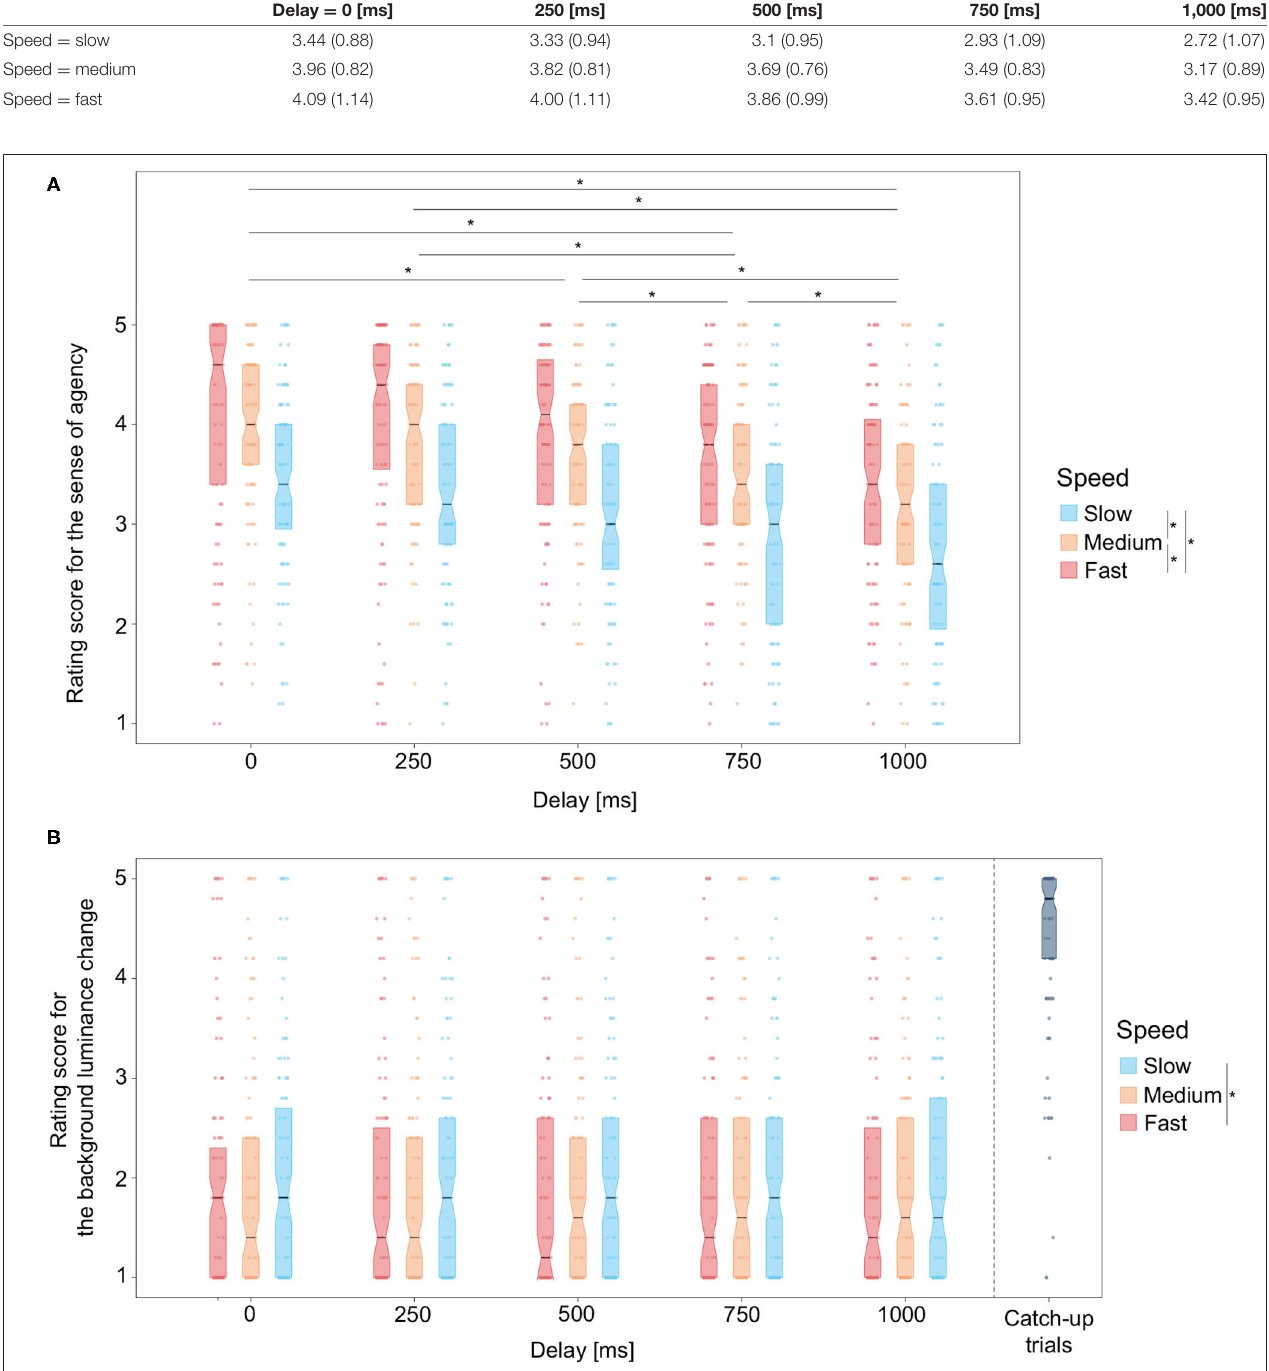
FIGURE 4 | Experiment 2 results. Box plots of (A) sense of agency rating scores and (B) background-luminance rating scores for each of the speed conditions as a function of the delay. Asterisks denote the pairs for which the means were significantly different using the EcolUtils package (Bonferroni-corrected p < 0.05). trial time, speed and stimulus duration, it is necessary to test scores. Upon the major role of the total trial time, it is probably conditions wherein these parameters are varied independently in natural to interpret the effect of speed as the effect of stimulus future studies. Unlike the results for SoA, the average scores for duration. To further disentangle the contributions of the total